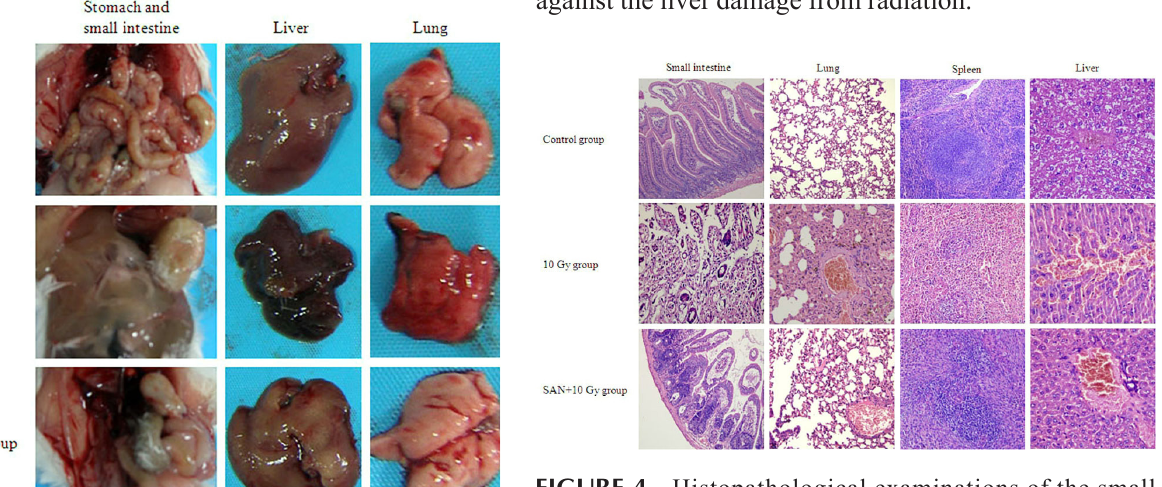
FIGURE 4 - Histopathological examinations of the small intestine, lung, spleen and liver at day 5